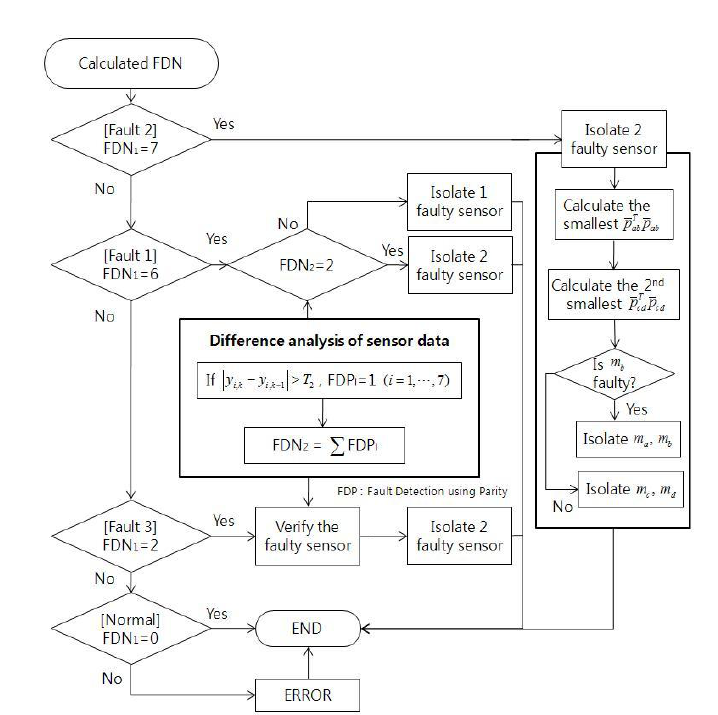
Figure 9. Fault isolation flow